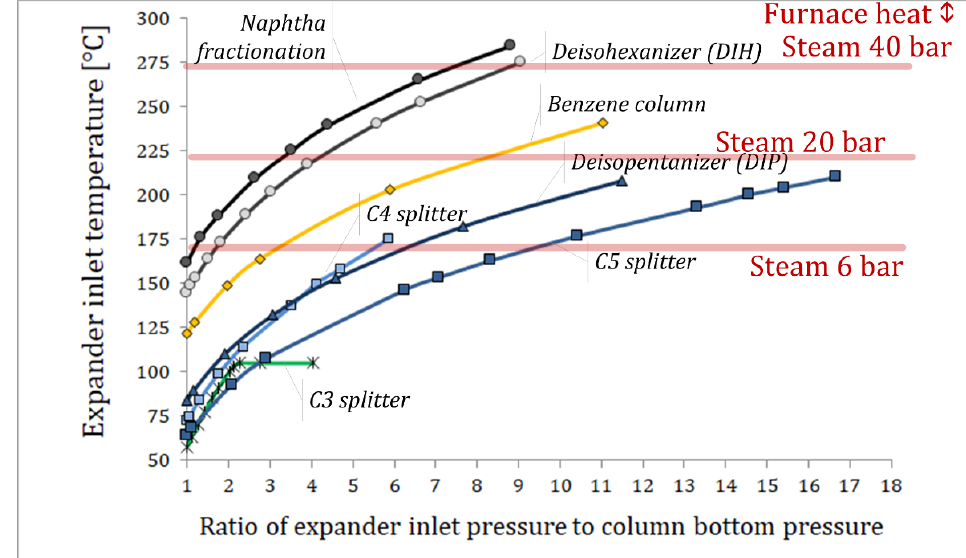
Figure 10. Influence of the pressure ratio at the expander inlet on the outlet temperature of the re-